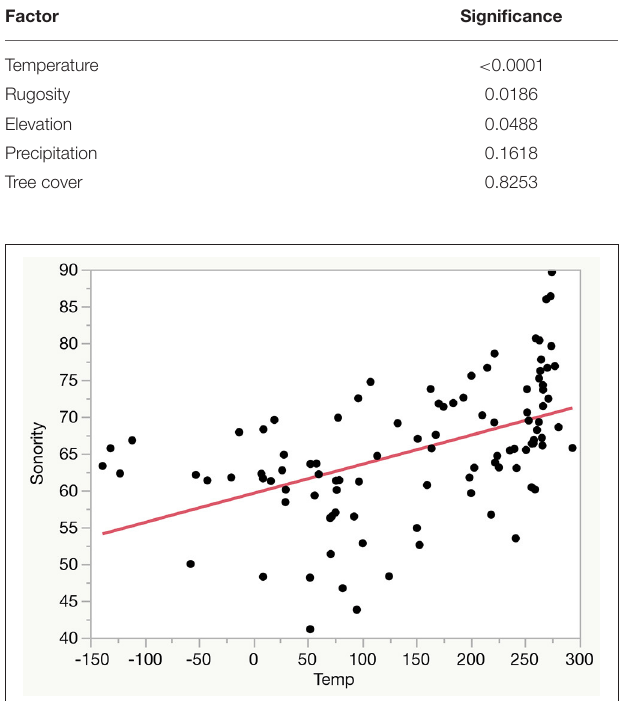
FIGURE 3 | Plot of sonority score vs. temperature for 100